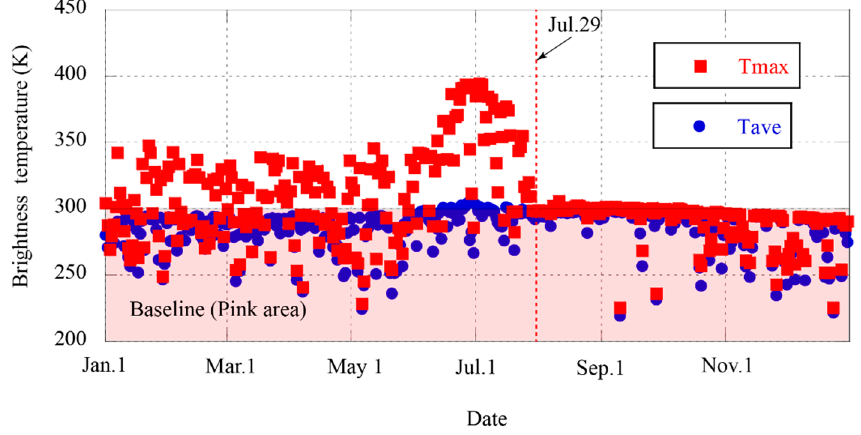
Figure 5. Time series of the maximum temperature (Tmax) and the average temperature (Tave) obtained from the 3.9 µm band of the Himawari-8 data around Nishinoshima Island in 2020. 3.3. Color Characteristics of Discolored Seawater Estimated from SGLI Data